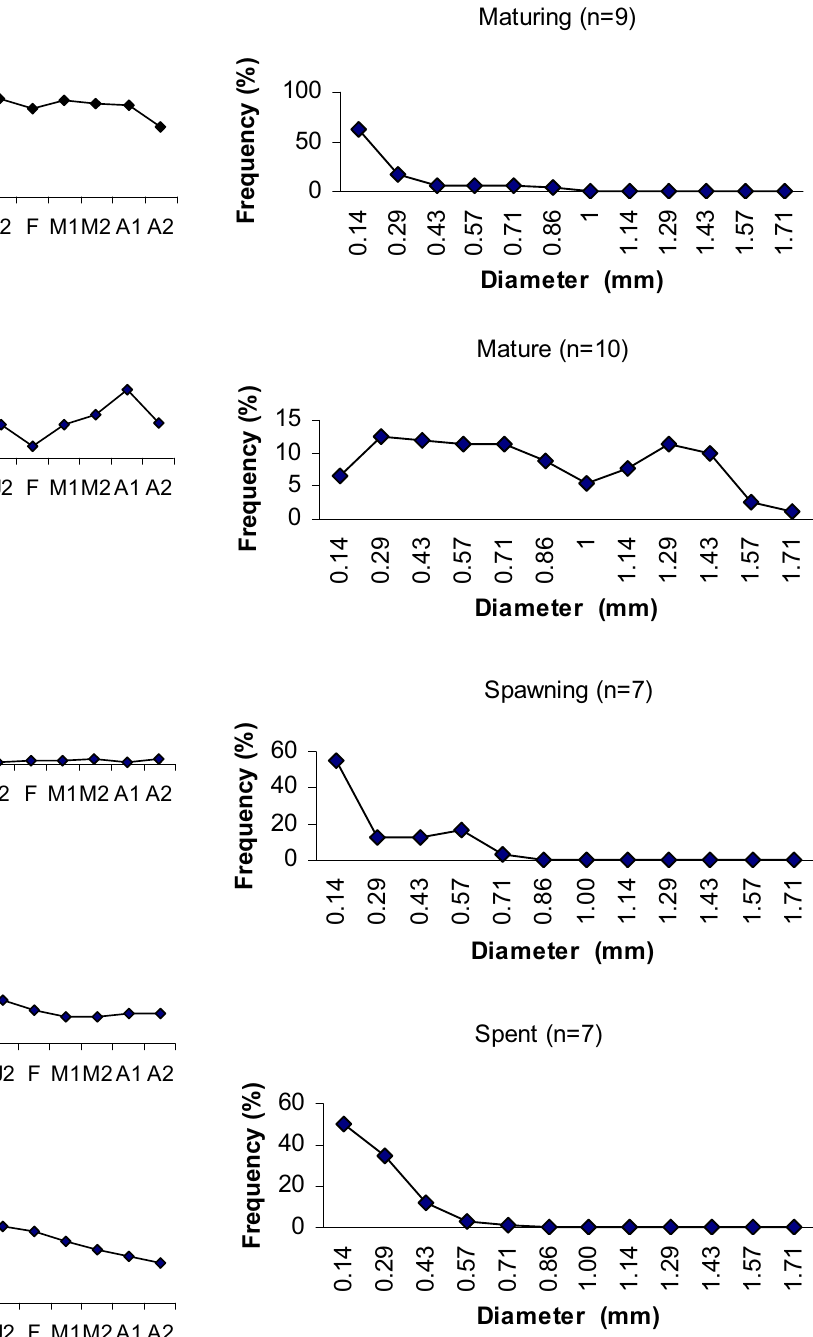
Fig. 6. Relative frequency distribution of oocyte diameter in four different stages of Gymnotus aff . carapo gonadal matu- ration in lagoa Verde, Itapuã State